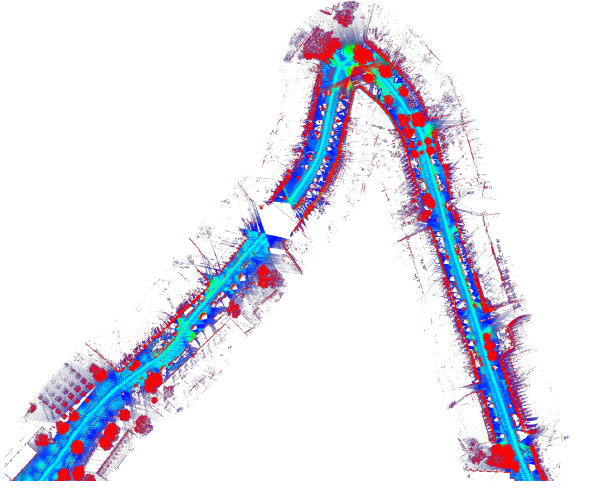
Figure 1: 2D map derived from mobile mapping point-cloud by eliminating the height property.